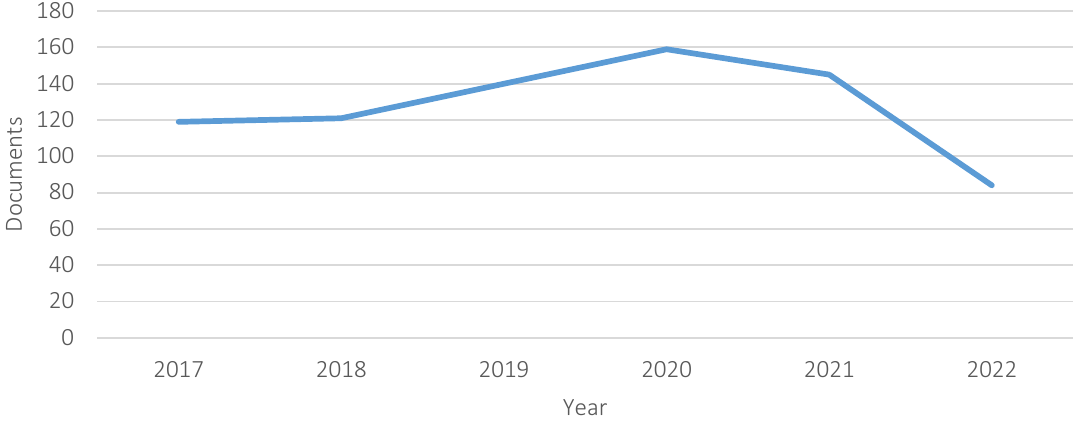
Figure 1. Dynamics of publications for the period 2017–2022